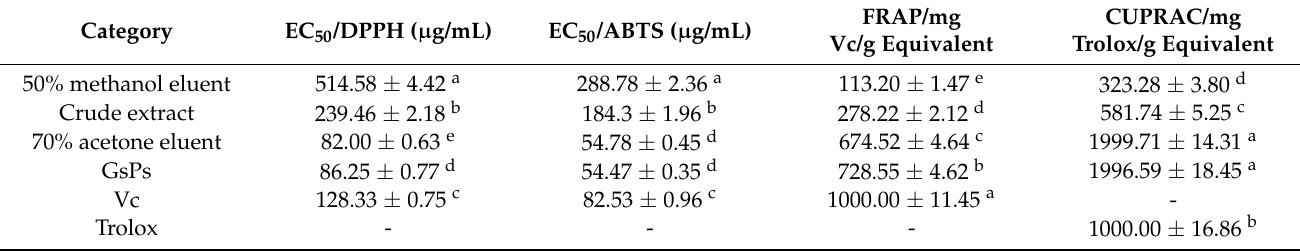
Different lowercase letters in each column indicate significant differences at the p < 0.05